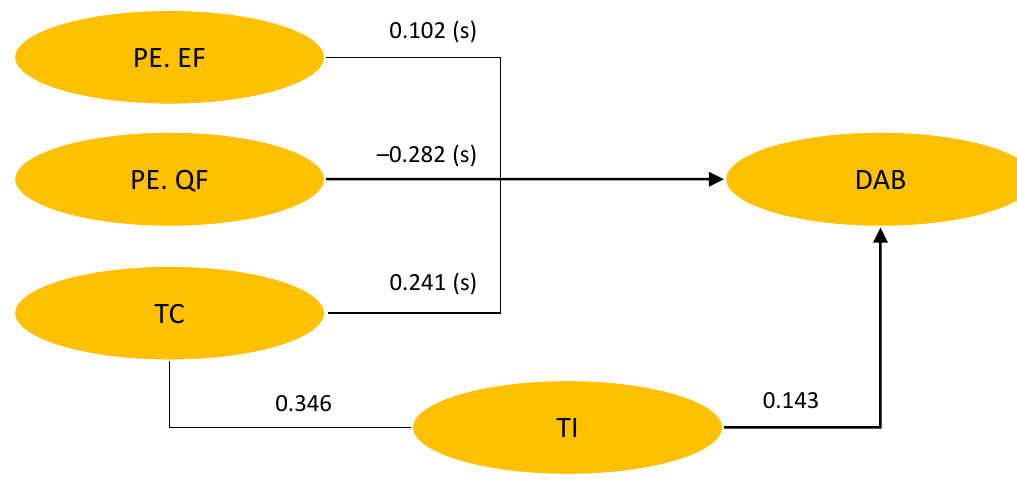
Figure 1. Diagram path dysfunctional behavior